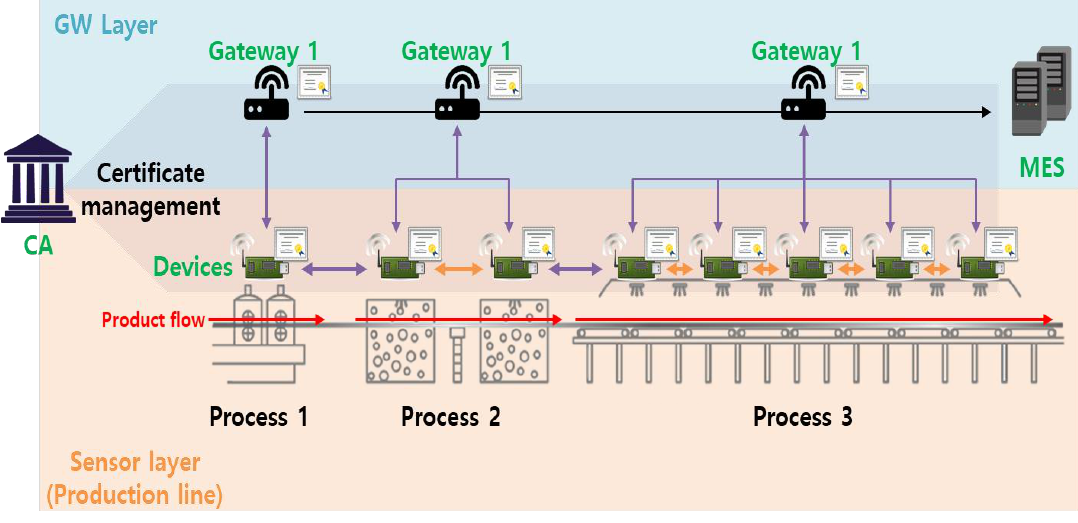
Figure 1. Example model: smart factory environments. MES, manufacturing execution system; CA, certificate authority.